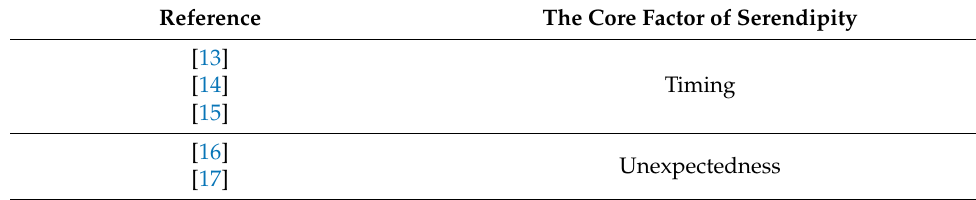
Table 1. A summary of related work.